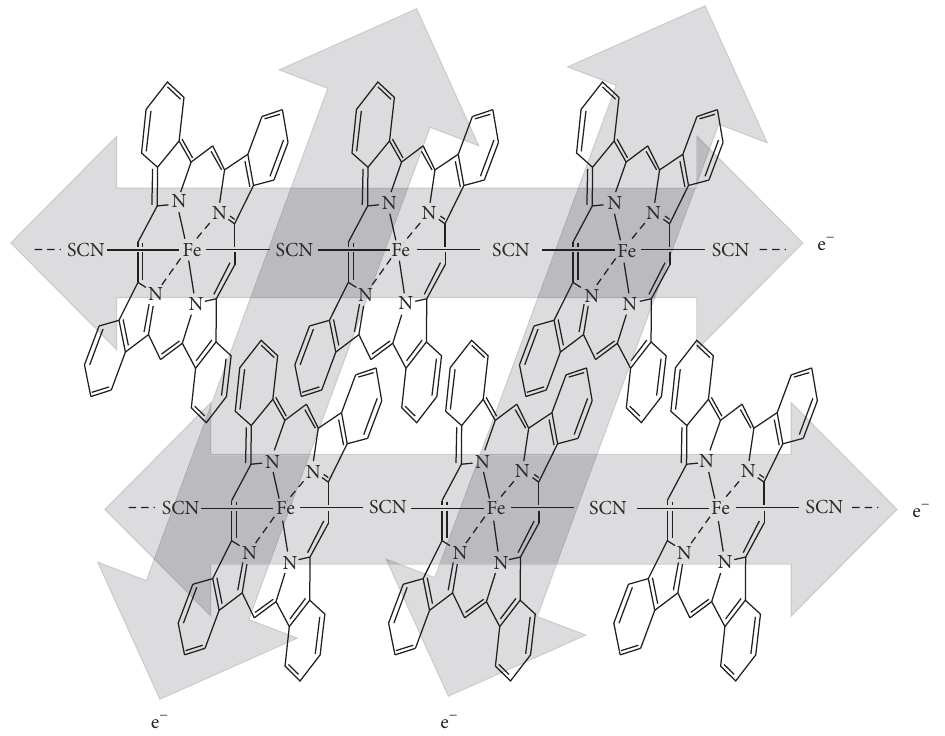
Scheme 3: Multidimensional electron conduction in [ FePcSCN ] 𝑛